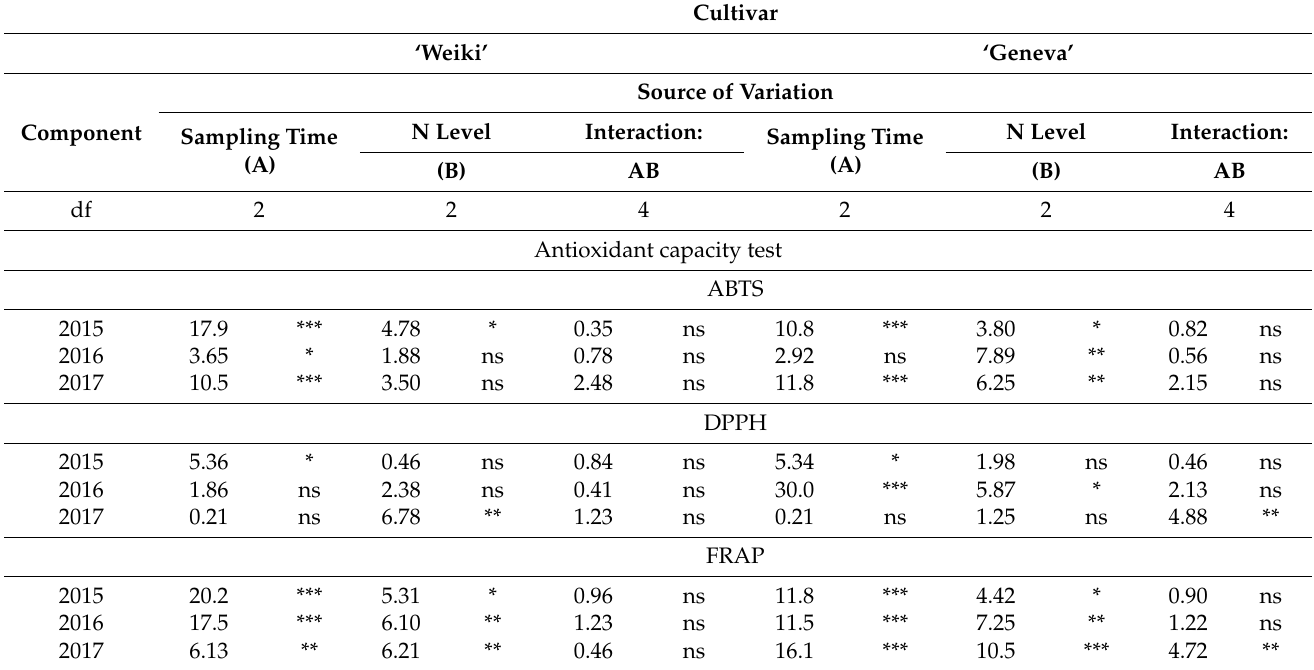
Table 3. Summary of analysis of variance (ANOVA) for antioxidant capacity tests. Values of F for particular sources of variation and their significance depending on the